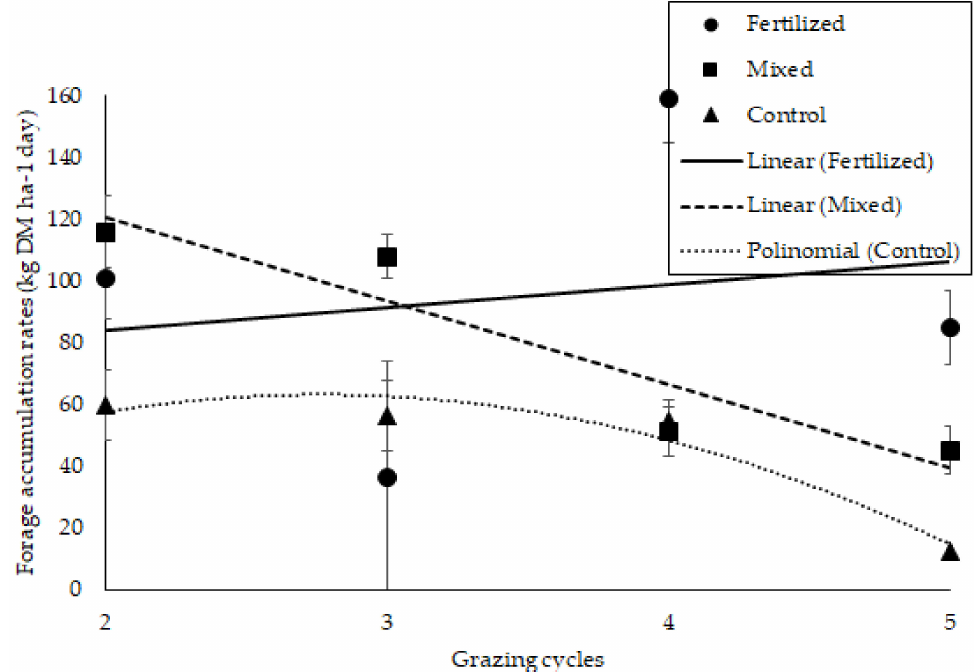
Figure 1. The herbage accumulation rate of palisade grass pastures fertilized with urea (150 kg N ha/year), mixed with pintoi peanut, and without N fertilization (control). Average of 2 years of evaluation of 5 grazing cycles ( n = 40). Circles: fertilized, squares: mixed, and triangles: control.